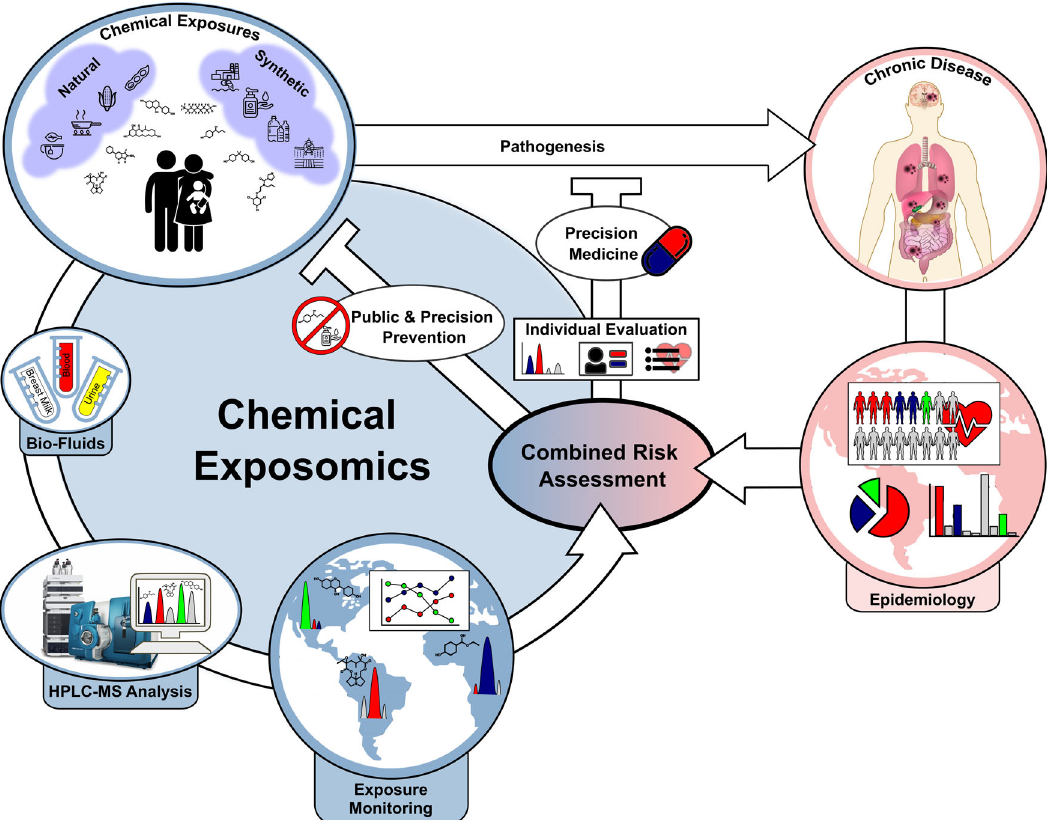
Fig. 1 Comprehensive exposomic biomonitoring and combined risk assessment. Schematic illustration depicting the application of a comprehensive exposome approach in an epidemiological setting to improve our understanding of the impact of chemical co-exposure on chronic disease. The prevention of disease will be aided by informed policy decisions and individualized precision